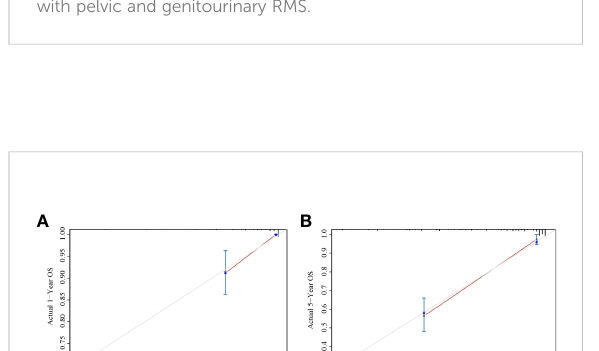
FIGURE 4 The nomogram of predicting CSS of patients aged 0-19 years with pelvic and genitourinary RMS.